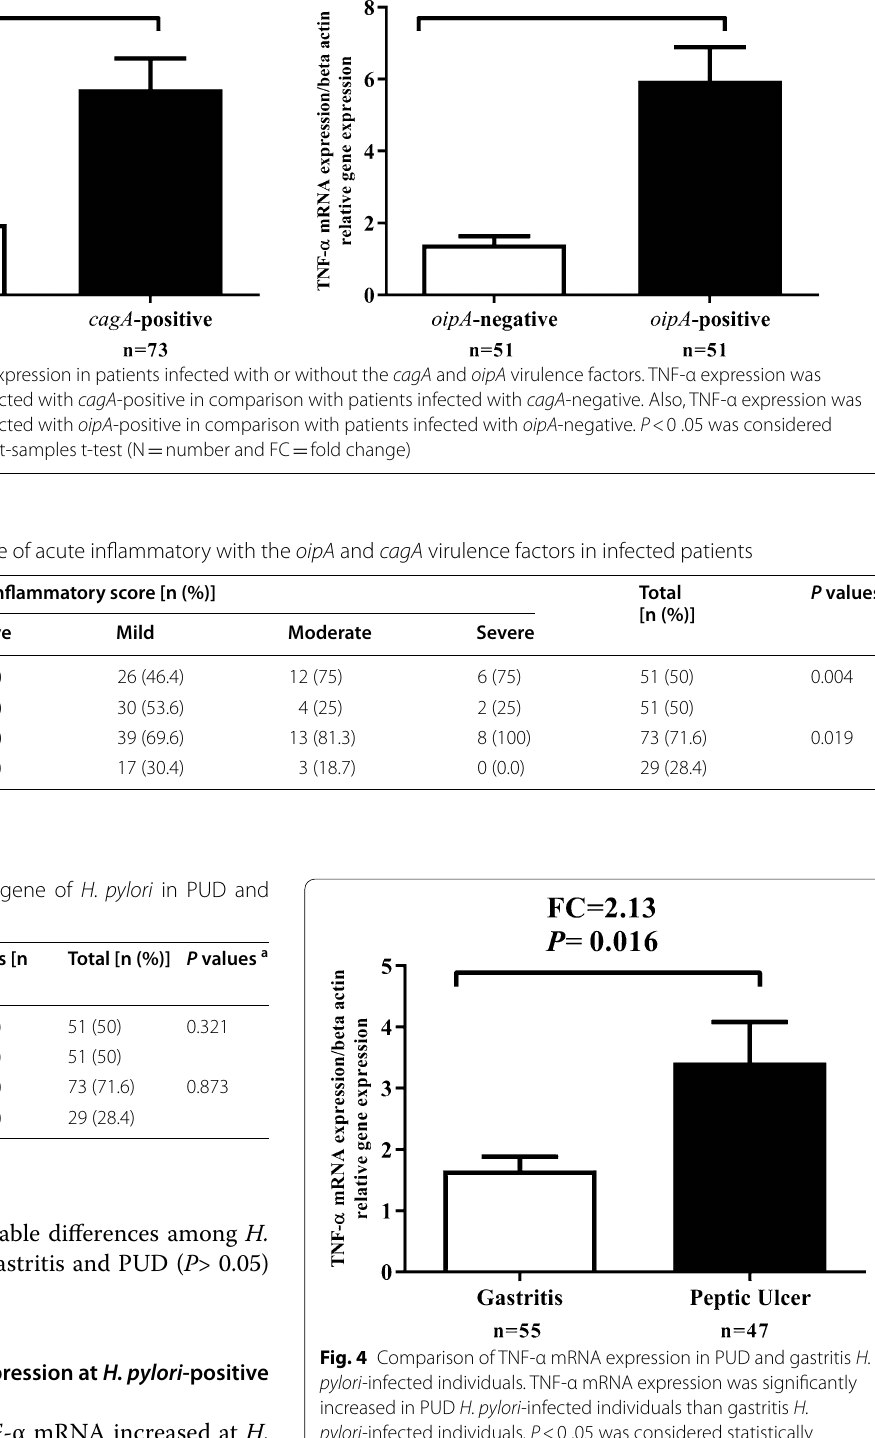
number and FC fold = =